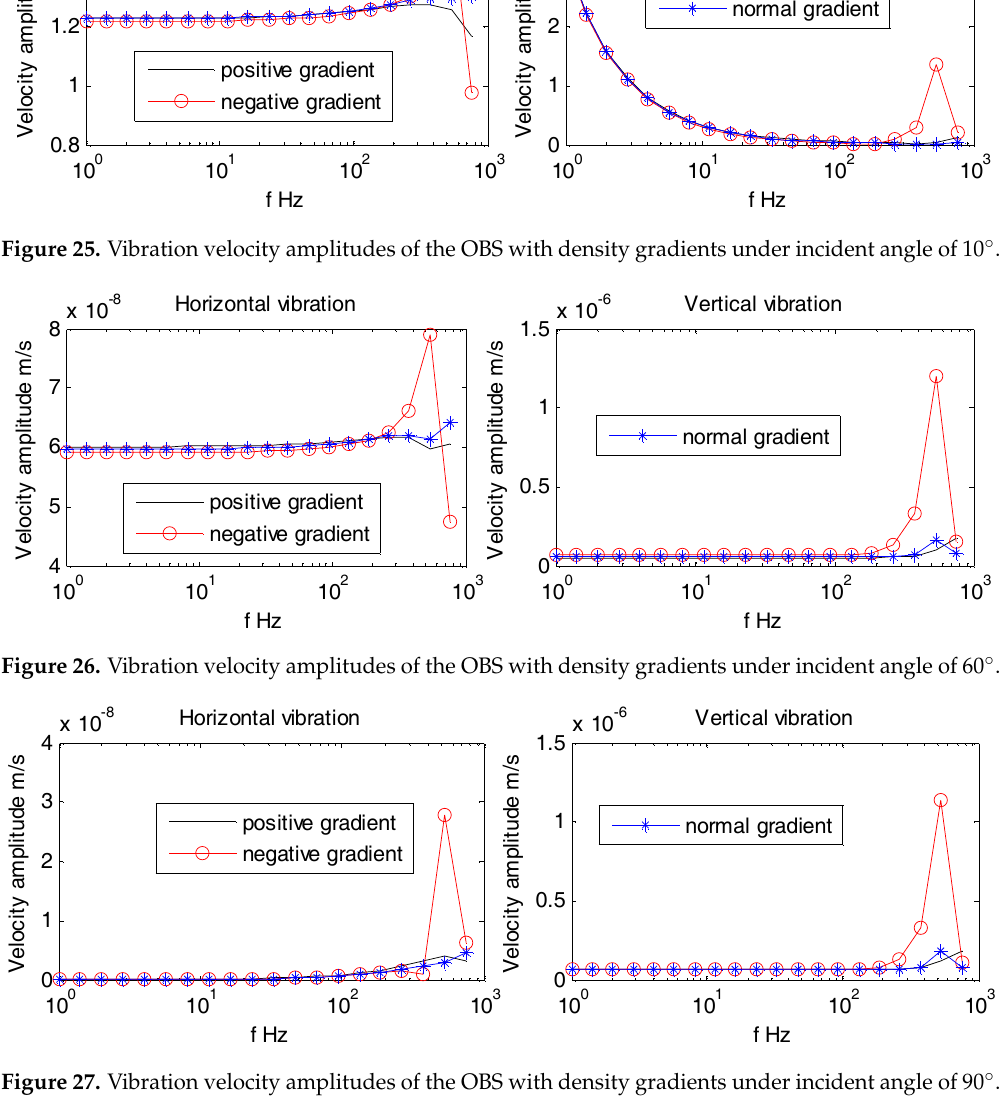
Figure 27. Vibration velocity amplitudes of the OBS with density gradients under incident angle of 90°.